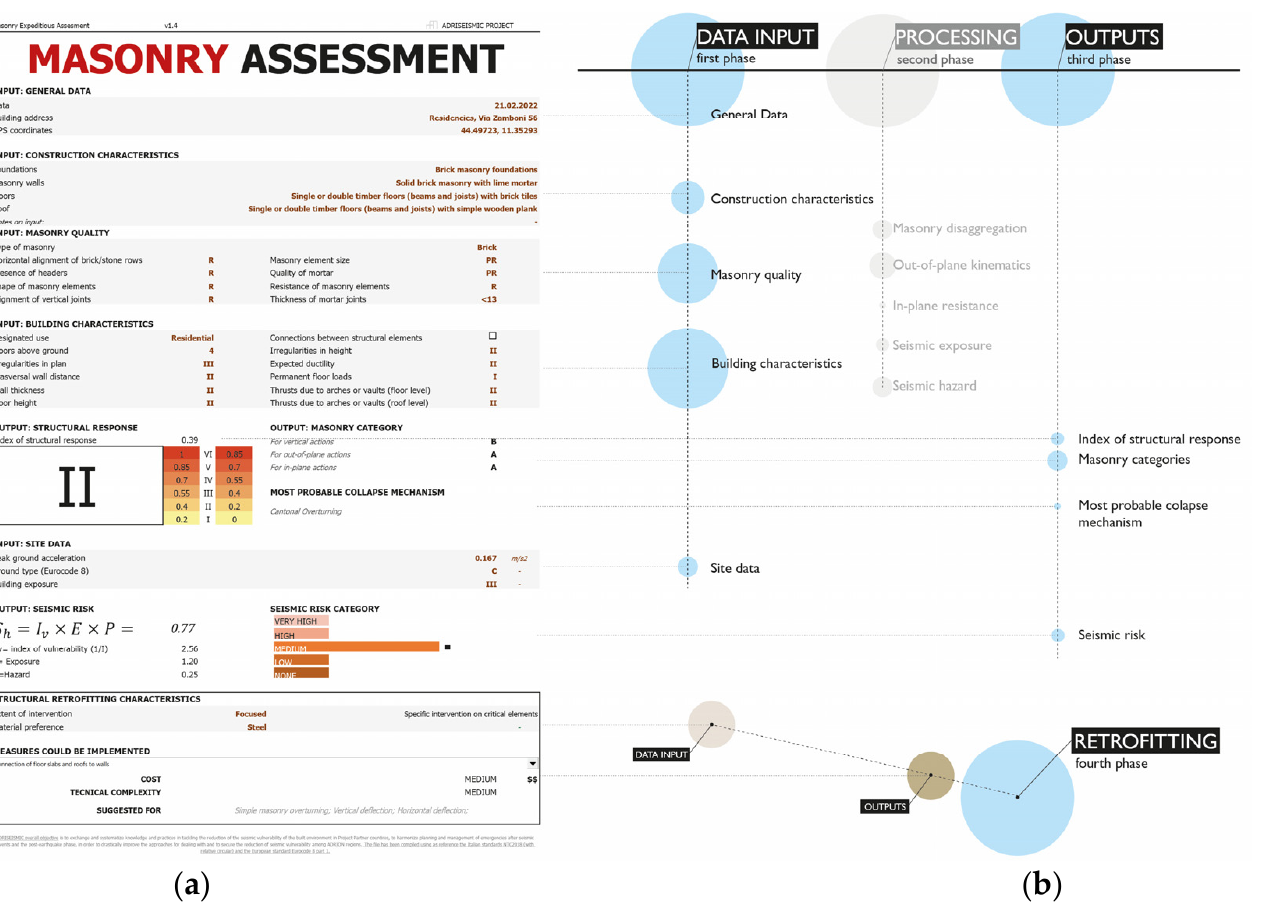
Figure 2. Adriseismic method: ( a ) assessment form, generated via a Microsoft Excel spreadsheet, showing input data and output (results), and ( b ) a diagram showing the main input categories (note that the processing phase is shown in grey).